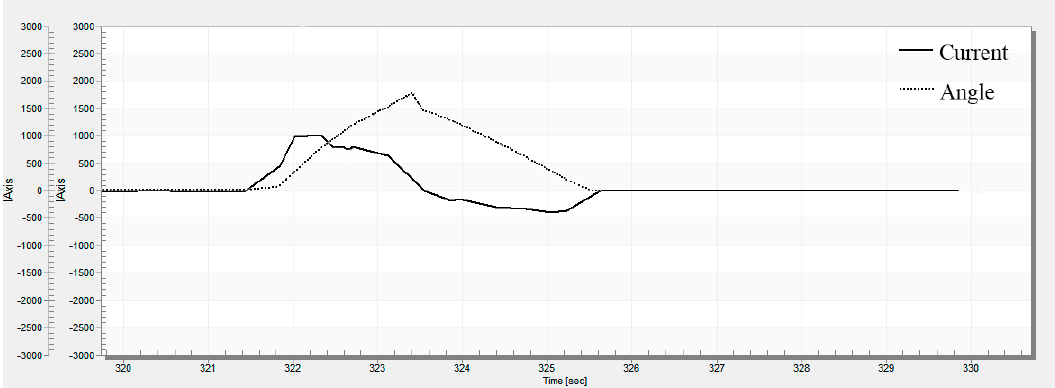
Figure 11. Motor’s current characteristic.